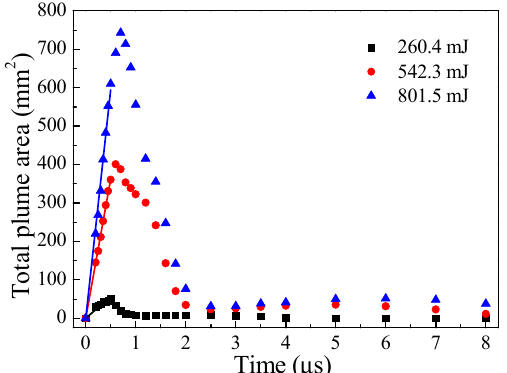
Figure 15. The plume length of first stage variation with time and its linear fitting at different energies (ambient pressure 0.005 Pa and 26.5% Al).